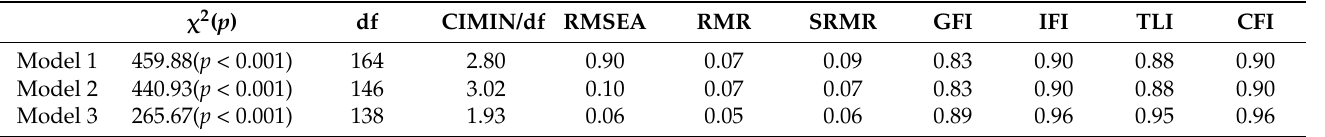
Table 2. Analysis of Construction